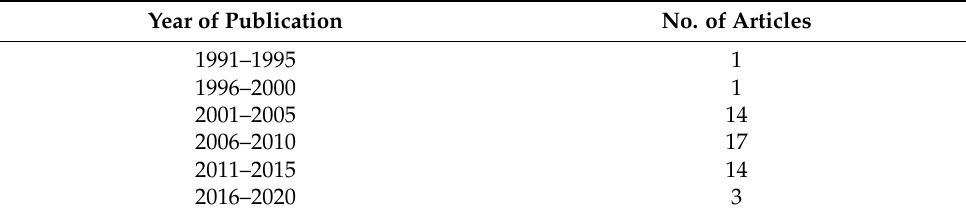
Table 4. Years of publication of the 50 most-cited papers on shoulder